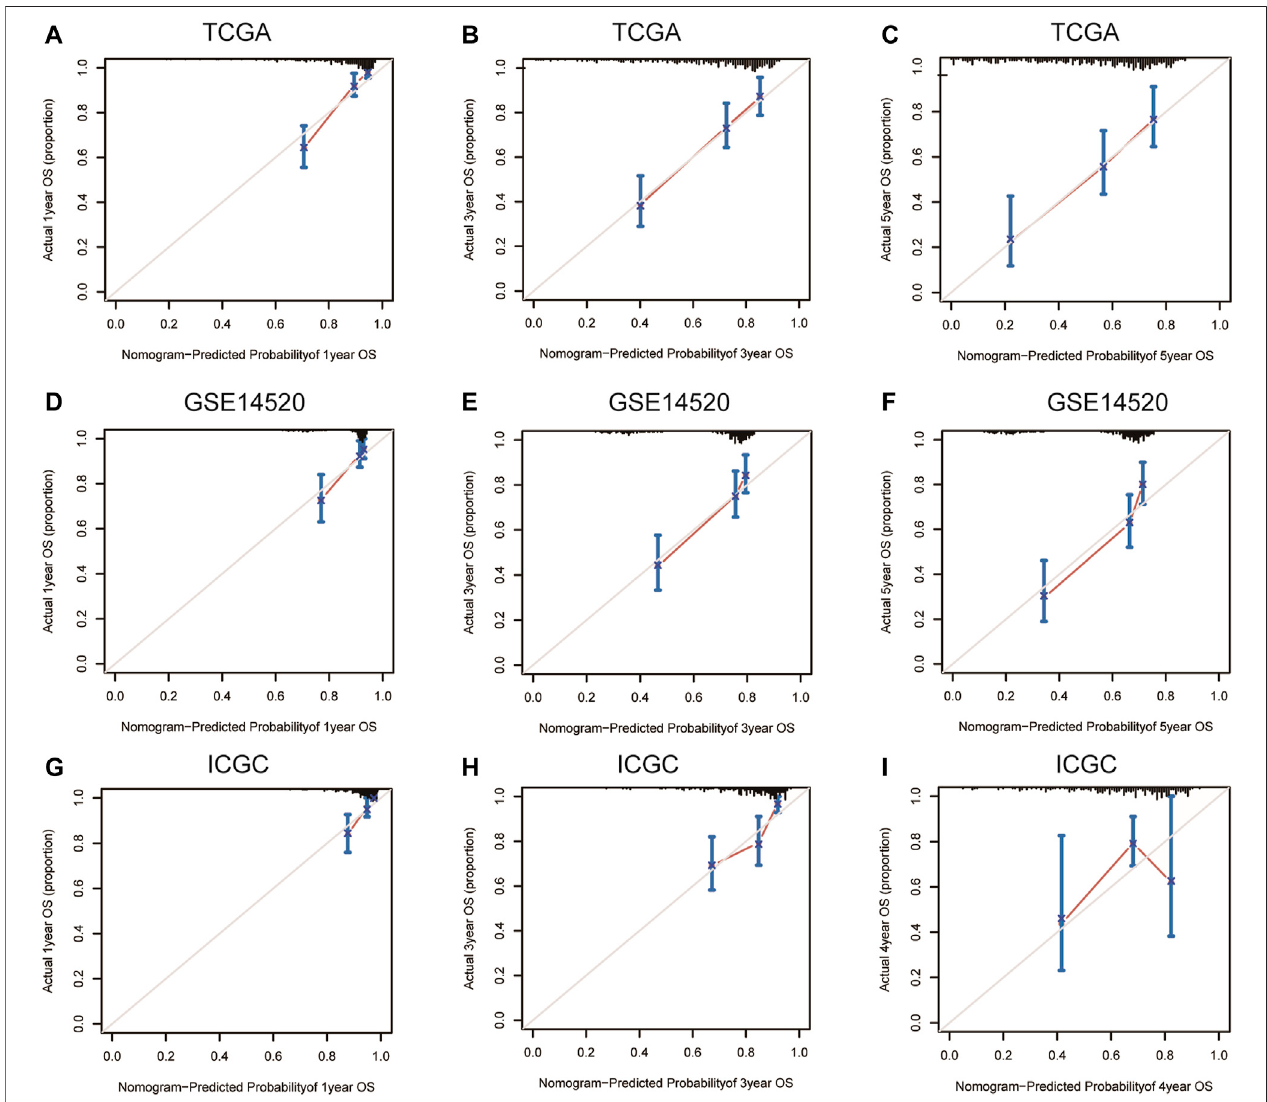
FIGURE 9 | 1-year, 3-year, and 5-year calibration curves of the nomogram model in TCGA (A – C) , GSE14520 (D – F) , and ICGC (G – I) OS dataset. Notes: TCGA, The Cancer Genome Atlas Program; ICGC, International Cancer Genome Consortium; OS, overall survival.